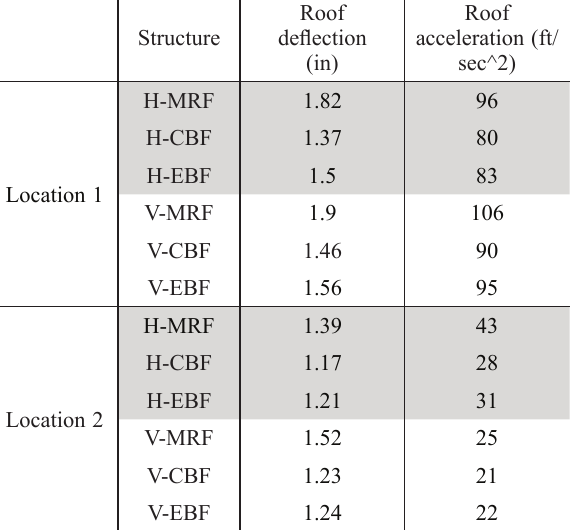
Table 9. Maximum roof deflection and acceleration for irregular MRf, eBf, and CBf